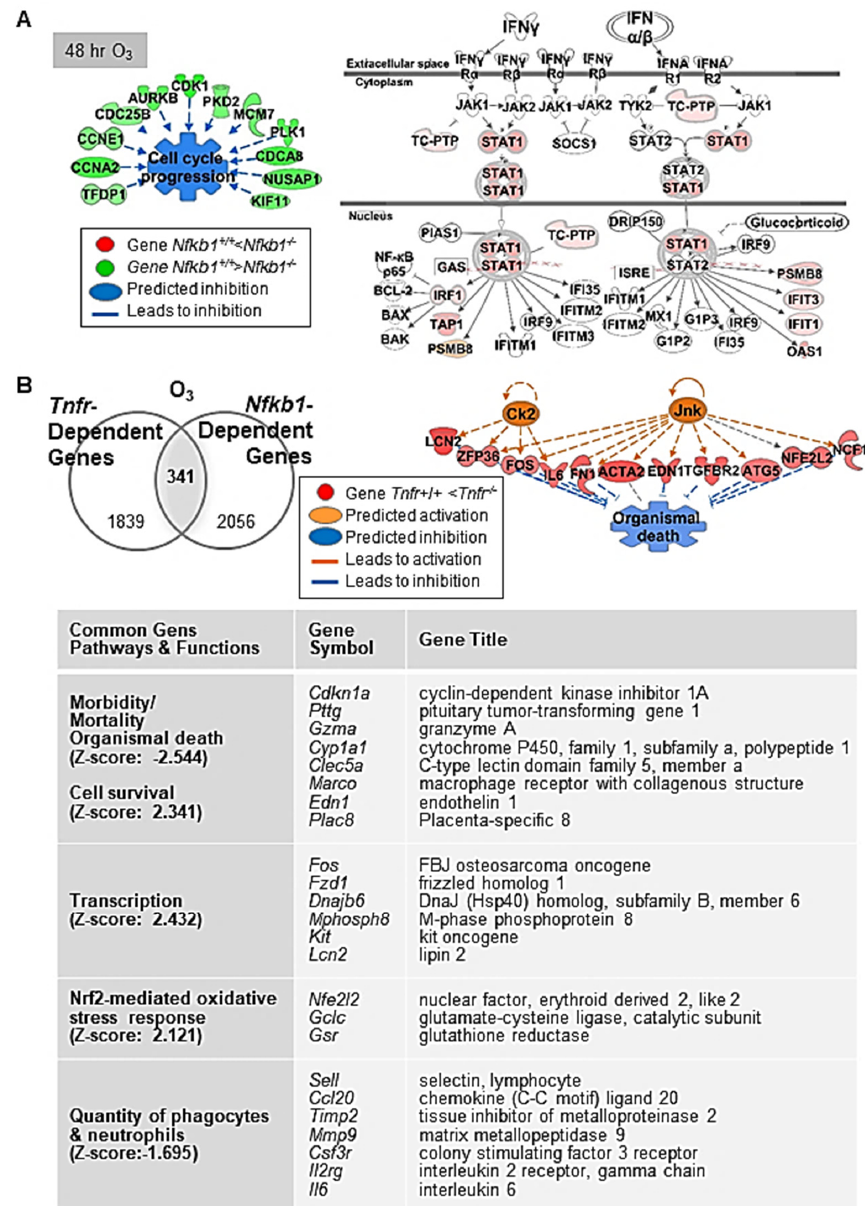
Figure 3. Nuclear factor kappa-light-chain-enhancer of activated B cells (NF- κ B) dependently regulated lung genes during ozone (O 3 )-induced lung injury development. ( A ) At 48 h O 3 exposure, downregulation of multiple genes in the family of cyclin (e.g., Ccnb1 ), cell division cycle (e.g., Cdca8 ), and centromere protein (e.g., Cenph ) in Nfkb1 -deficient mice ( Nfkb1 -/- ) compared with wild-type ( Nfkb1 +/+ ) mice was marked, suggesting suppressed cell proliferation and enhanced DNA damage checkpoint regulation pathways in Nfkb1 -/- mice. In contrast, heightened interferon (IFN) signaling genes (e.g., Irf1 , Psmb8 , Tap1 , and Stat1 ) and predicted activation of upstream regulators (e.g., IRF7 and IFN type I receptor) indicated an enhanced innate immunity in Nfkb1 -/- mice than in Nfkb1 +/+ mice during O 3 -induced lung injury development. ( B ) Common differentially regulated genes between Tnfr +/+ and Tnfr -/- , and Nfkb1 +/+ and Nfkb1 -/- ( n = 341) were determined by Venn diagram analysis. Transcriptome signatures of TNFR/NF- κ B-axis mediated pulmonary O 3 toxicity were predicted to modulate cell/organism death and survival, transcriptional regulation, oxidative stress, and inflammation ( B ). Gene or molecule colors for ( A , B ) indicate upregulation/activation (red/orange) or downregulation/inhibition (green/blue) in Nfkb1 -/- mice compared with Nfkb1 +/+ mice after O 3 exposure. Analyses were done using Ingenuity Pathway Analysis and GeneSpring software.